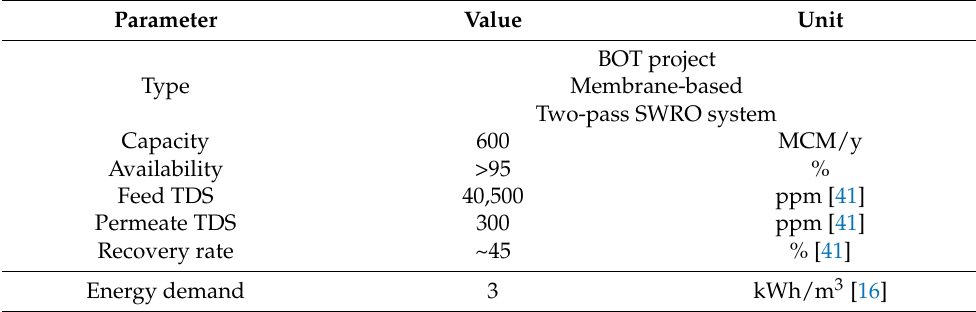
Table 2. Technical parameters for the reverse osmosis desalination plant.